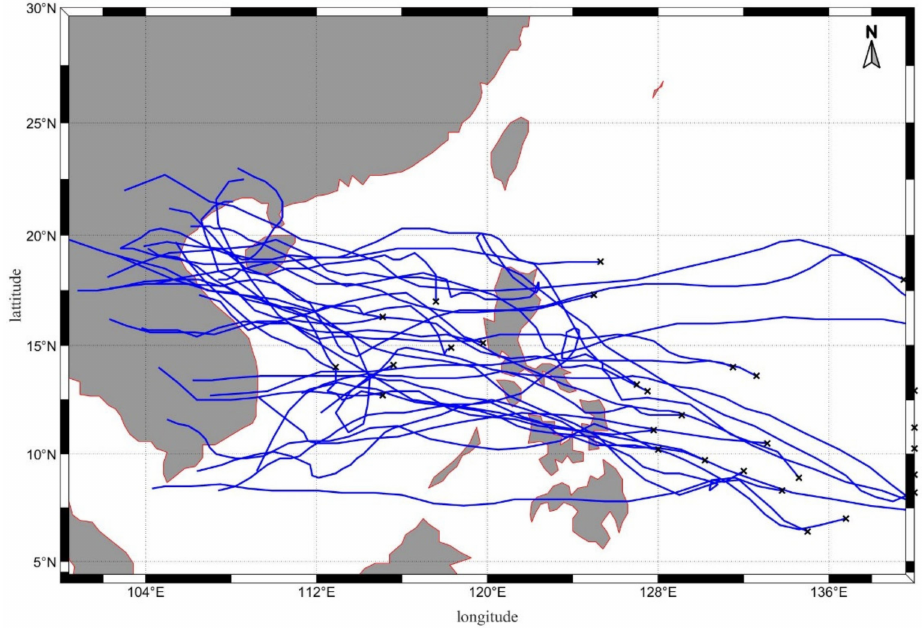
Figure 2. The best path of westward typhoon crossing the South China Sea from 1998 to